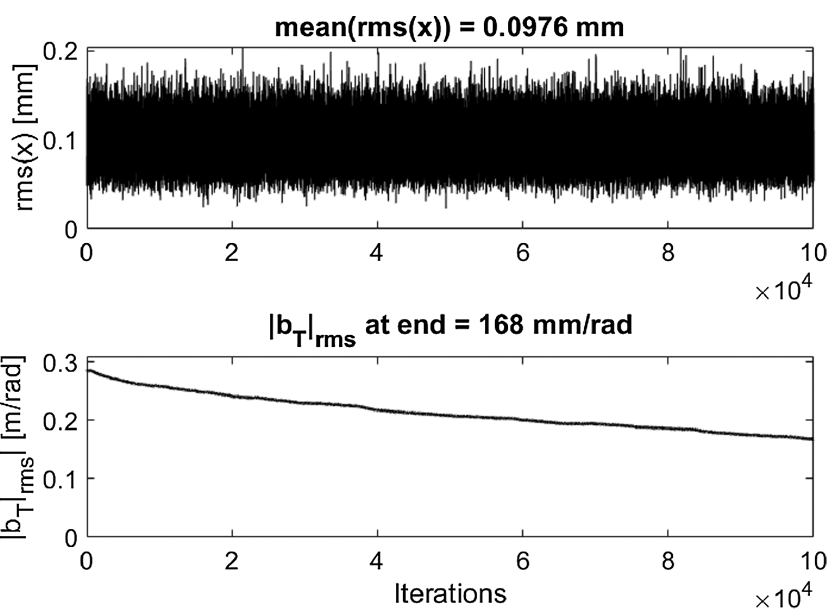
ffiffiffiffiffiffiffiffiffiffi p FIG. 2. The rms orbit (top) and the rms of all matrix elements of B − h x j x i σ 0 . 1 mm. The upper plot reproduces the noise level and the lower graph shows that the response-matrix estimate ˆ B slowly w ¼ converges toward B